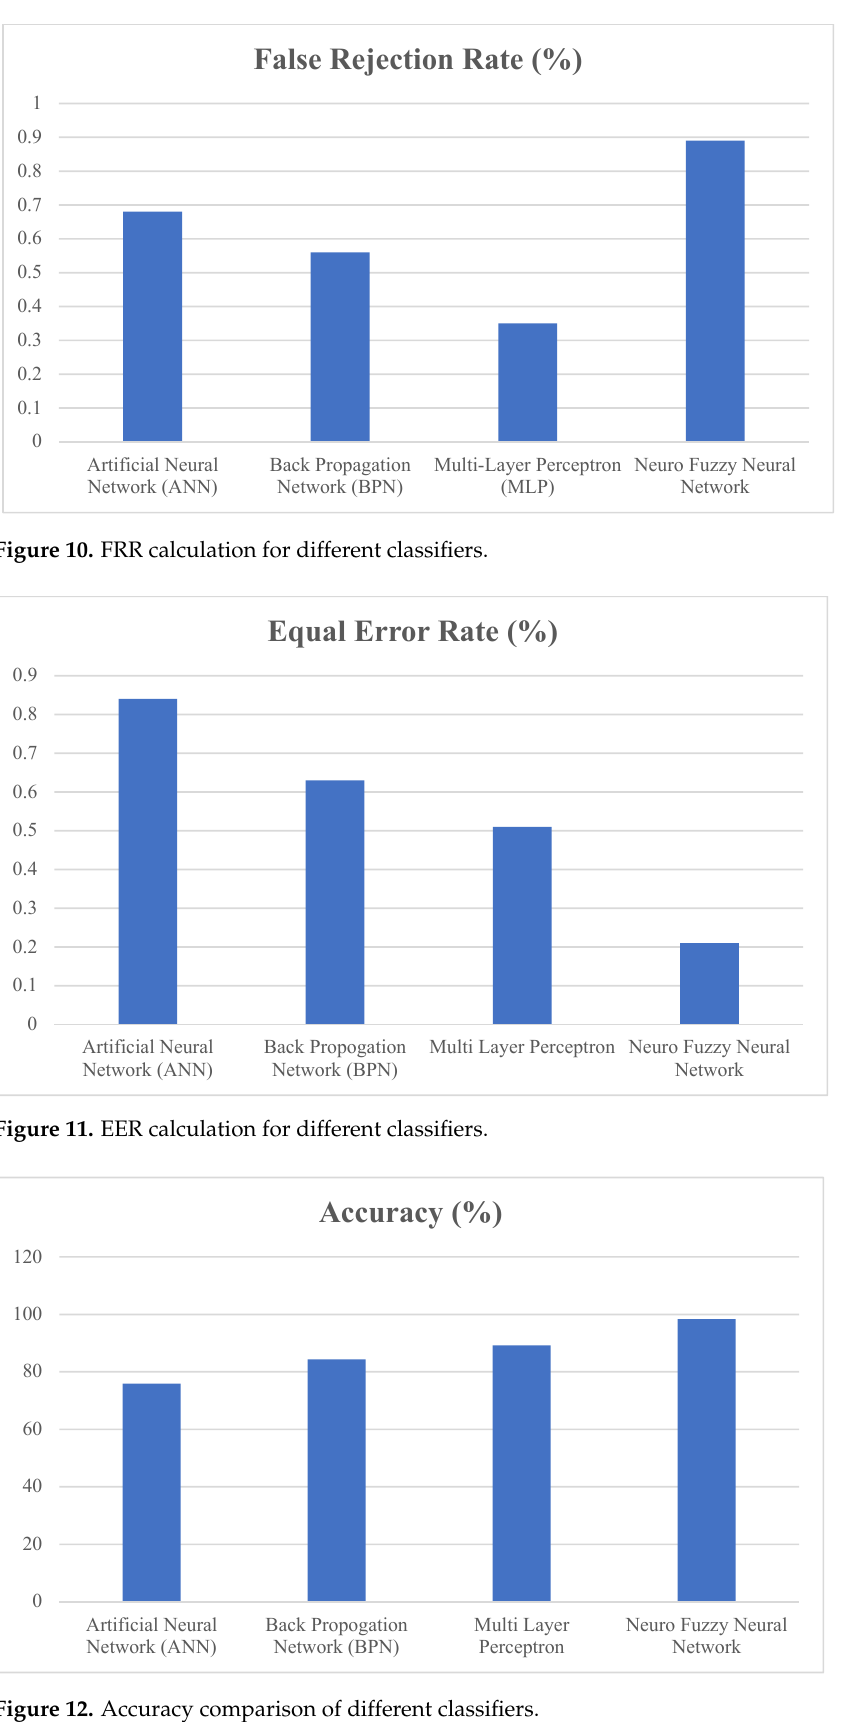
Figure 9. FAR calculation for various classifiers.